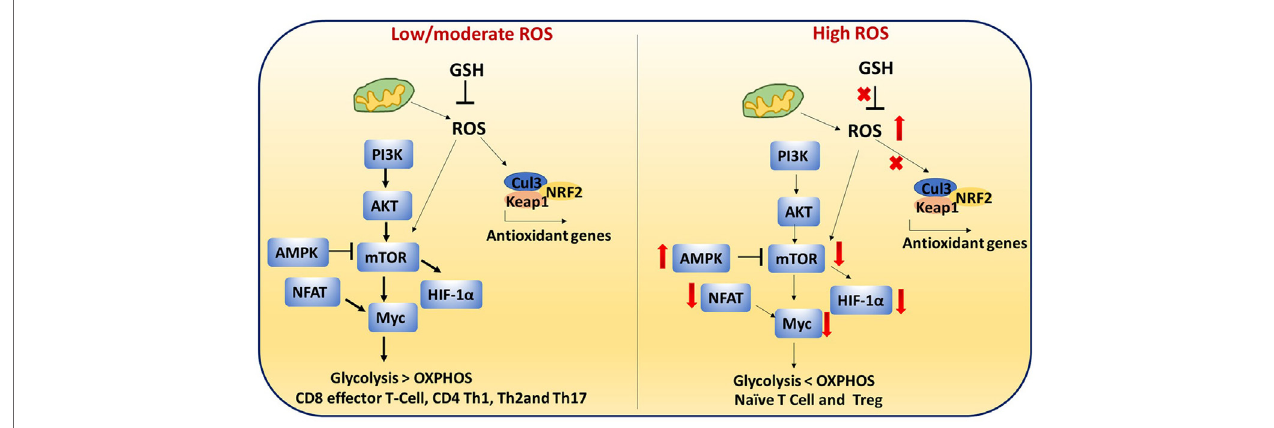
FiguRe 8 | Reactive oxygen species (ROS)-mediated cell signaling in T cells: low/moderate levels of ROS promote mTOR, Myc, and nuclear factor of activated T cell (NFAT) activation which is associated with increased glycolysis and inflammatory response in T cells. ROS levels are regulated by the glutathione pathway (GSH) and NRF2–Keap1–Cul3 trimeric complex. Abrogation of GSH and the trimeric complex, which may cause high levels of ROS, impairs the inflammatory response of T cells. In addition, high ROS and high adenosine monophosphate-activated protein kinase (AMPK) levels inhibit mTOR. It is reported that naïve T cells, CD4 + regulatory T cells, and chronically stimulated T cells depend on OXPHOS as their primary metabolism method while CD8 + effector and CD4 + Th1 cells mainly depend on glycolysis. This metabolic switching is controlled by